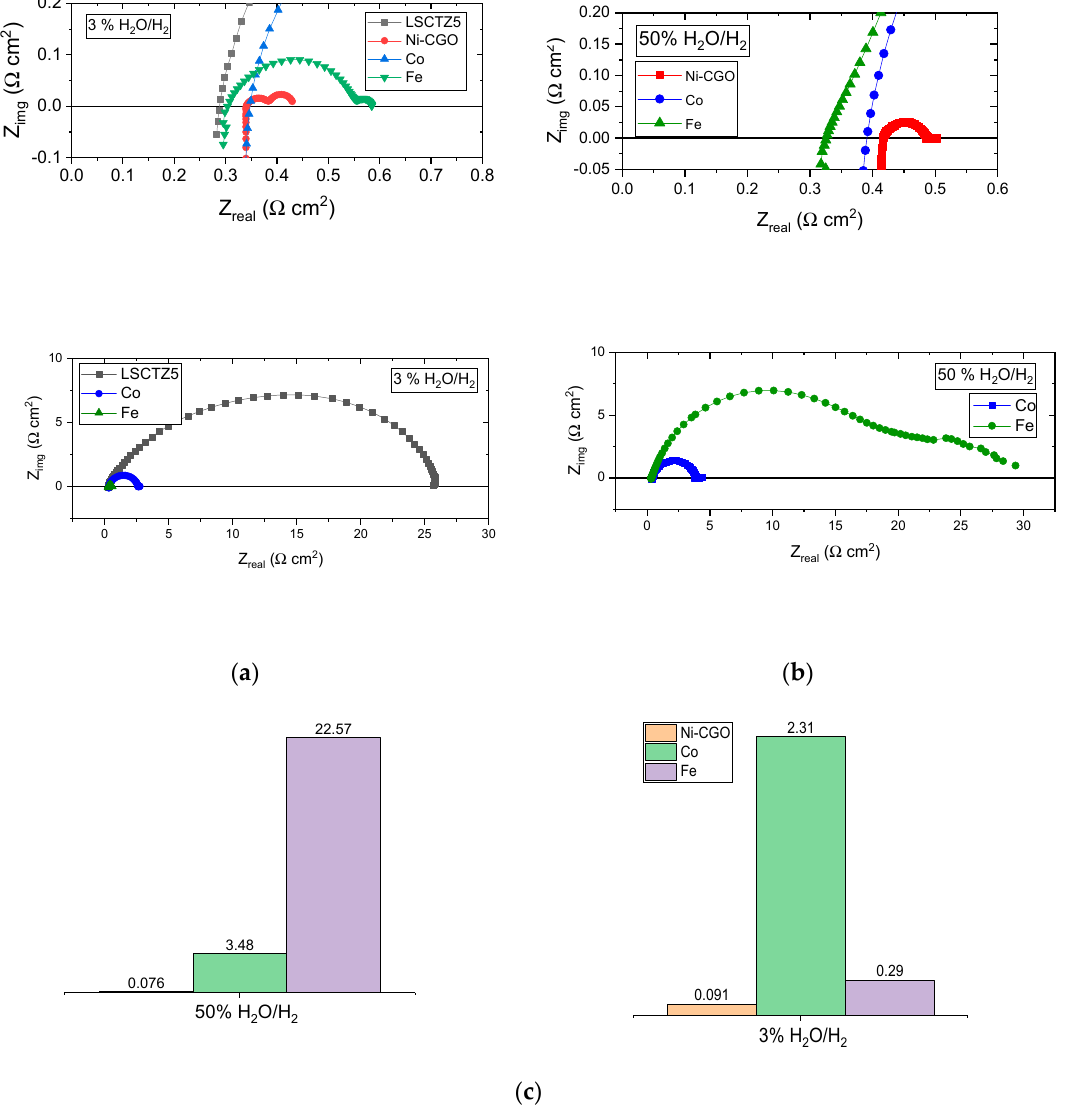
Figure 4. Electrochemical impedance spectroscopy (EIS) data Nyquist plot from Ni-CGO-, Co- and Fe-infiltrated LSCTZ5 at 750 °C in ( a ) 3% H 2 O/H 2 and ( b ) 50% H 2 O/H 2 ; the high frequency intercept is magnified in a separate ( c ) bar graph plot for comparison with R p values given in Ω cm 2 .